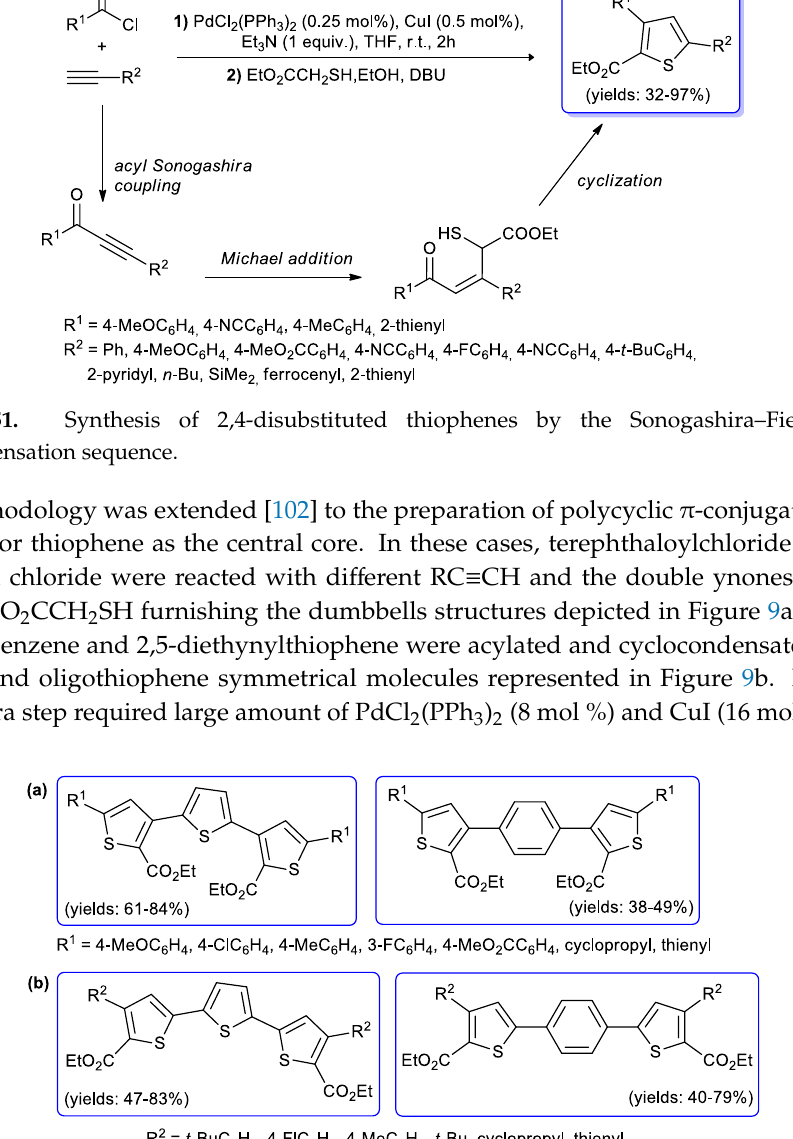
Figure 9. Polycyclic π -conjugated oligomers containing benzene or thiophene as the central core synthesized by Müller and co-workers.